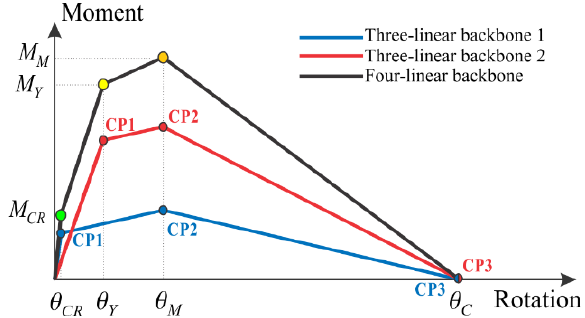
Figure 3. Schematic presentation of coupling two three-linear moment–rotation relationships in parallel in order to obtain a four-linear moment–rotation relationship in a flexural plastic hinge.